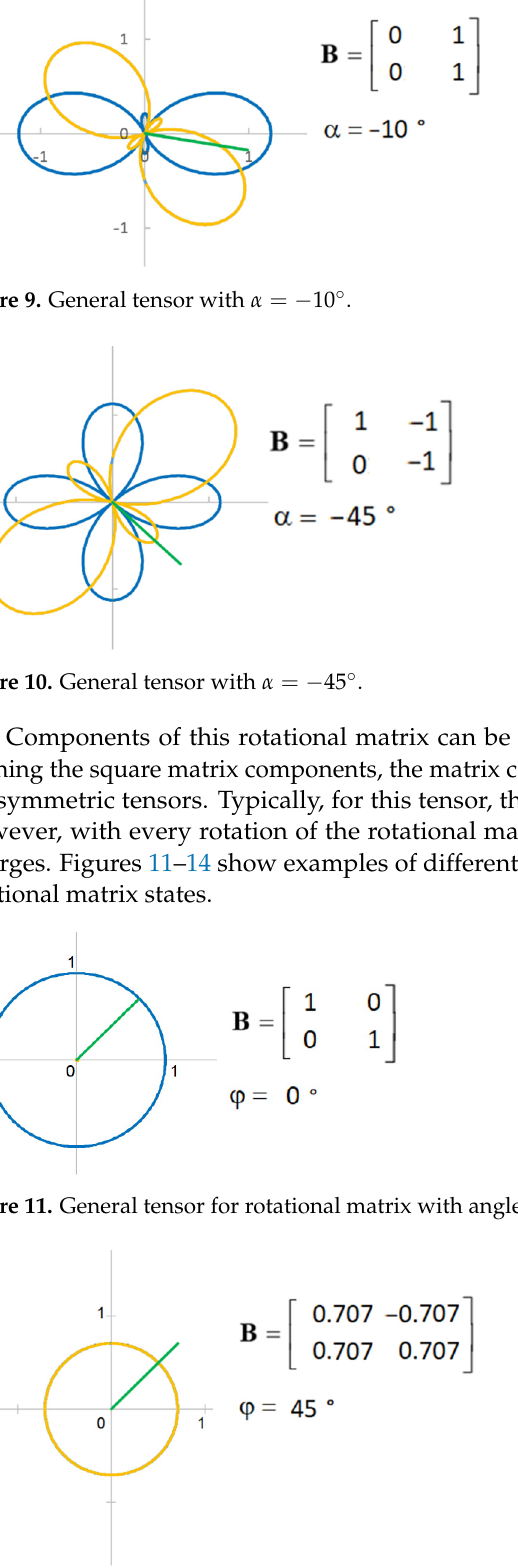
Figure 8. General tensor with 𝛼 = 45° .